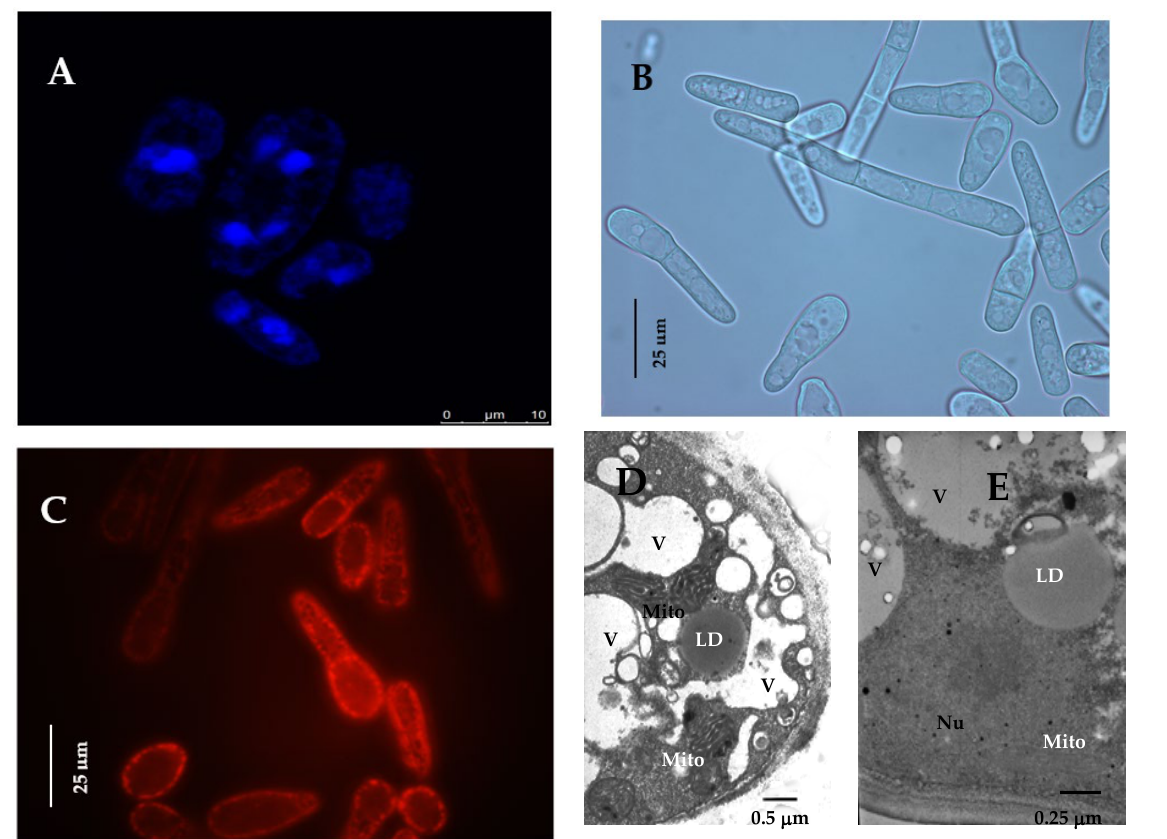
Figure 1. Micro images of the E. magnusii cells in the logarithmic growth stages. ( A ) Fluorescent micro-images of the cells, labeled with 0.3 µ M DAPI for DNA; ( B ) mycelial form of cells; ( C ) the potential-dependent stain of the mitochondria in E. magnusii cells by 5 mM Rh123. The regions of high mitochondrial polarization are bright red due to the concentrated dye. The cells were examined after 30 min. The incubation medium contained 0.01 M phosphate-buffered saline (PBS) and 1% glycerol, with a pH of 7.4. To examine the Rh123-stained preparations, filters 02, 15 (Zeiss) were used (magnification 100 × ). Photos were taken using an AxioCam MRc camera: ( D , E )-ultrastructure